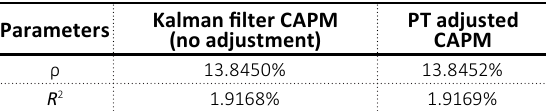
Table 3. Correlation of adjusted CAPM returns to